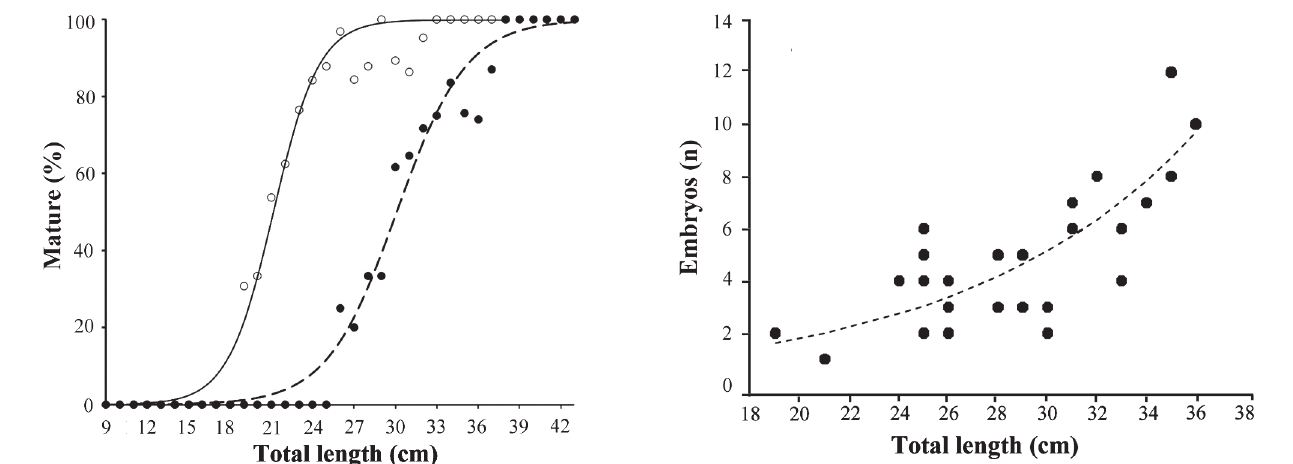
) for Discopyge tschudii . N e